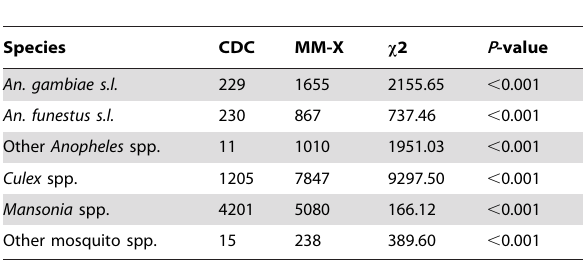
Table 1. Total number of each mosquito species/genusof both sexes caught by each type of